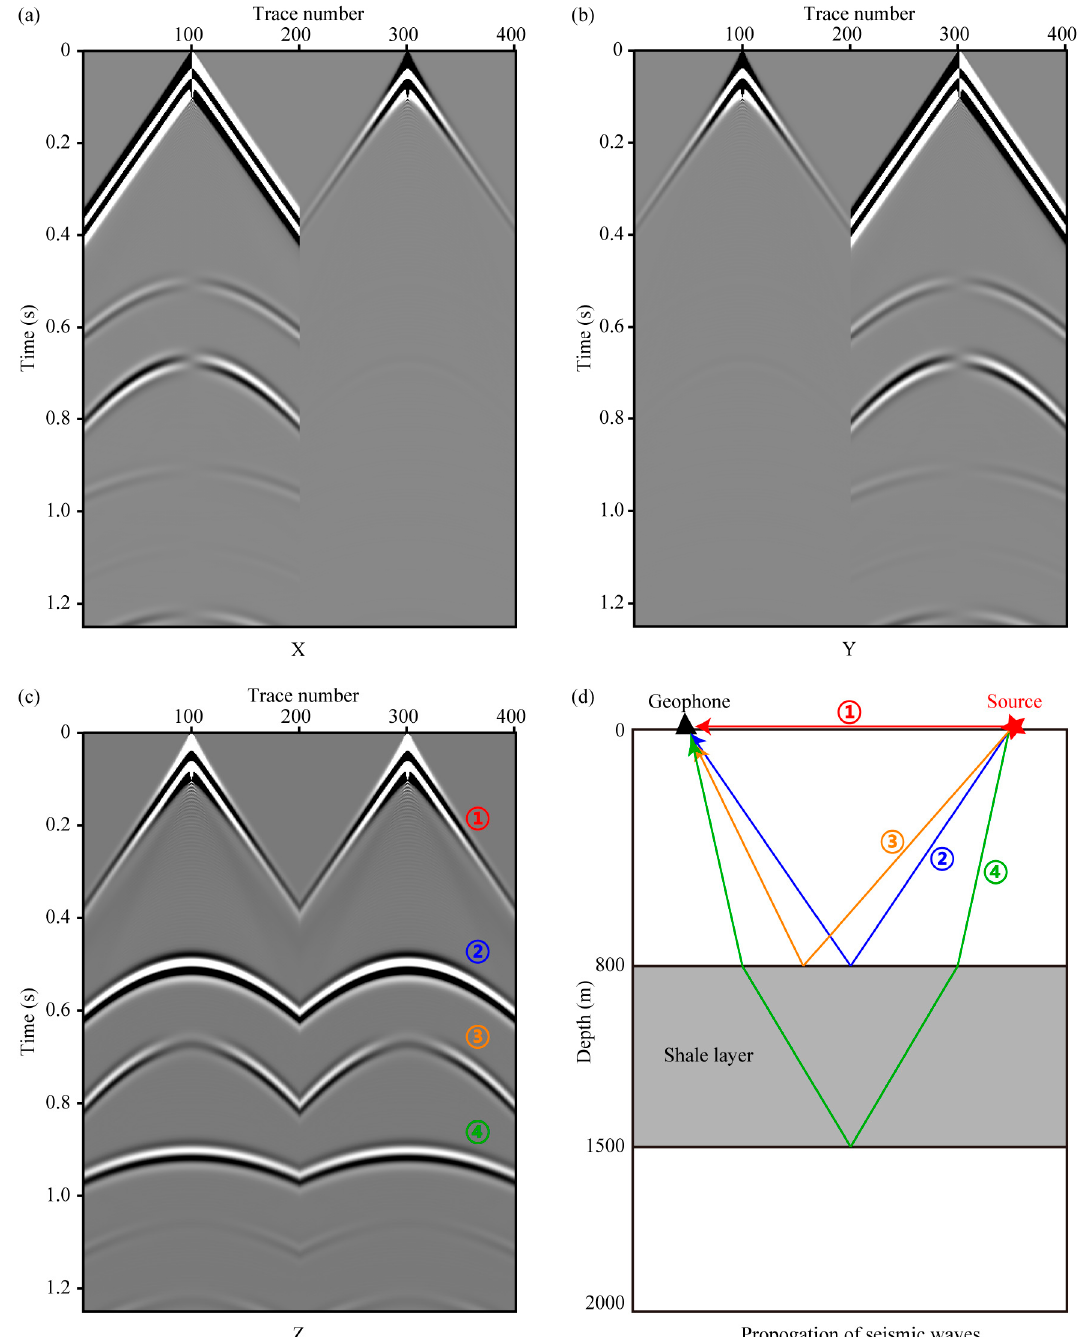
Figure 3. Three-component seismic wavefield of the M 0 model and corresponding wave propagation diagrams of four seismic phases. ( a )/( b )/( c ) are the geophones’ X/Y/Z waveform records, respectively, ( d ) indicates the seismic wave propagation paths corresponding to each phase, with ○ 1 direct P wave, ○ 2 reflected P-P wave, ○ 3 reflected P-SV wave, and ○ 4 P-P-P-P wave.